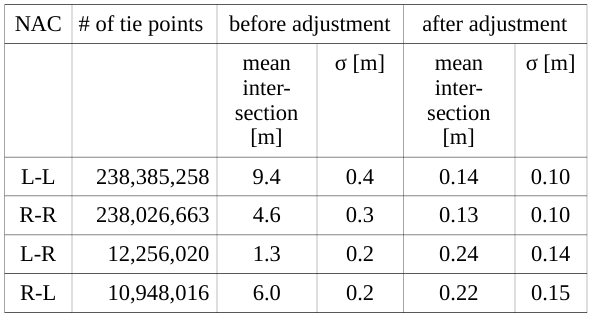
Table 1. Mean ray intersections and their standard deviations before and after the bundle adjustment.